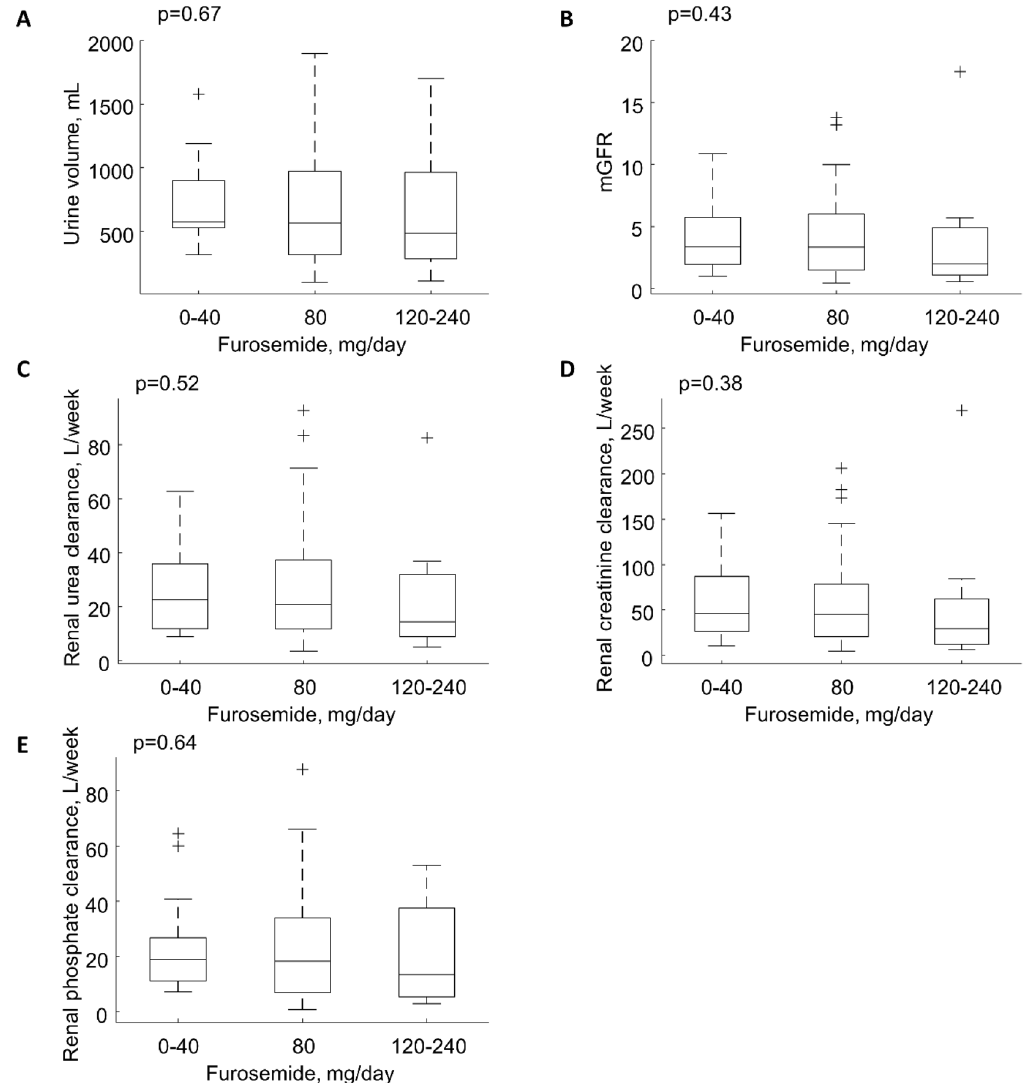
Figure 4. Urine volume (panel A ), measured glomerular filtration rate (mGFR, panel B ), renal urea (panel C ), creatinine (panel D ) and phosphate (panel E ) clearance vs. daily dose of